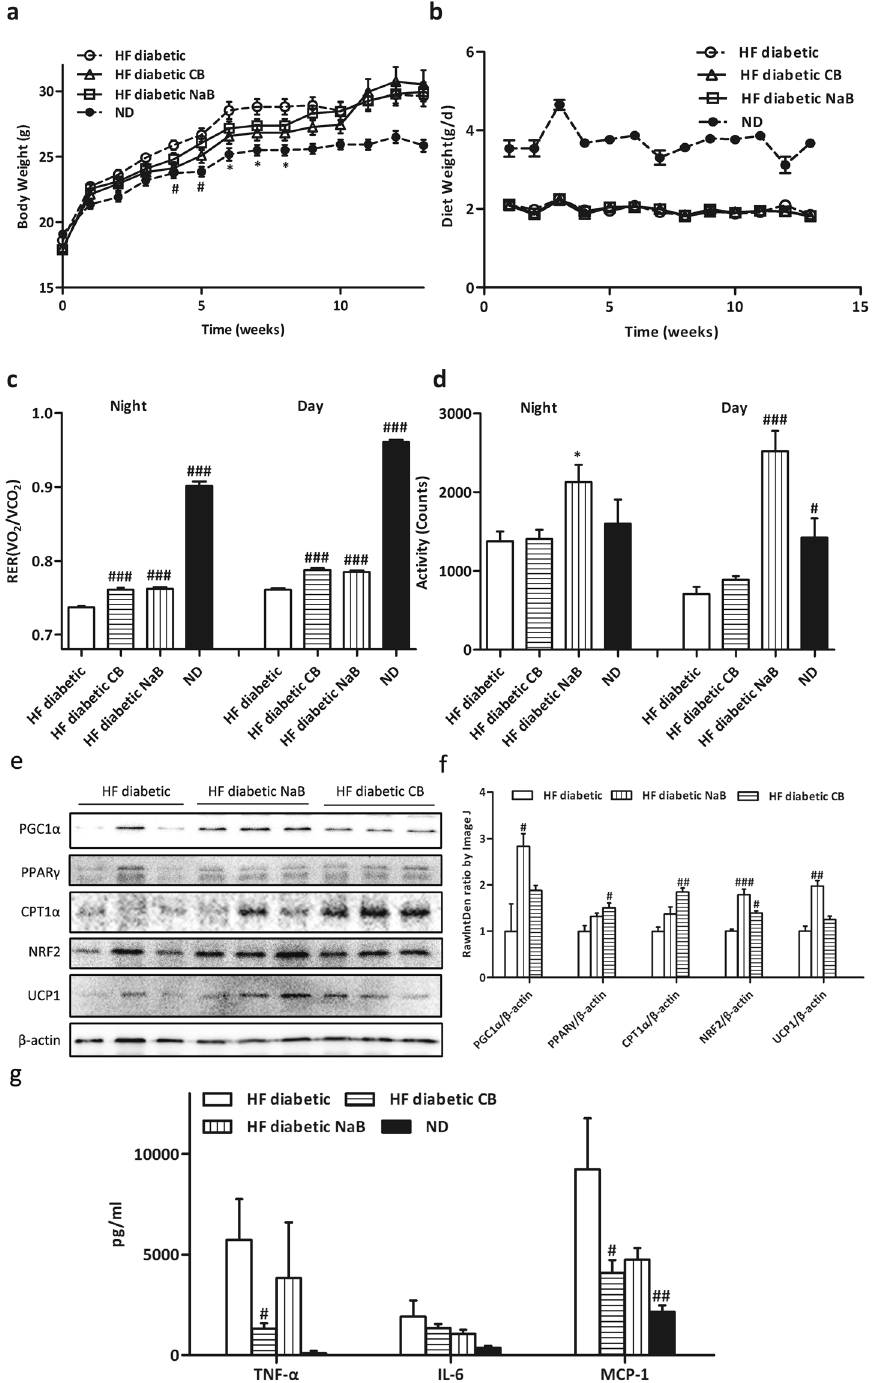
Figure 3. CB0313.1 mitigates energy metabolic dysfunction via reducing inflammatory tone in adipose tissue in HF diabetic mice. Energy expenditure was examined using a metabolic chamber at 17 weeks of age. Body weight ( a ) and food intake ( b ) were monitored weekly; ( c ) Substrate utilization is expressed by respiratory exchange ratio (RER), the ratio of O 2 consumption to CO 2 exhalation volume; ( d ) Spontaneous physical activity; ( e and f ) Western blot analysis of mitochondrial metabolism proteins: PGC1 α , PPAR γ , CPT1 α , NRF2, UCP1 and β -actin as housekeeping protein (n = 3); ( g ) Related protein levels of inflammatory markers determined by ELISA. Data are mean ± SEM (n = 3–8 mice per group). #, ##, ### p < 0.05, p < 0.01, p < 0.001 vs HF diabetic control by one-way ANOVA followed by the indicated post hoc test. * , ** , *** p < 0.05, p < 0.01, p < 0.001 vs HF diabetic control by t -test. HF diabetic: high fat diet and streptozotocin, HF diabetic CB: high fat diet and streptozotocin plus CB0313.1, HF diabetic NaB: high fat diet and streptozotocin plus NaB, ND: Normal